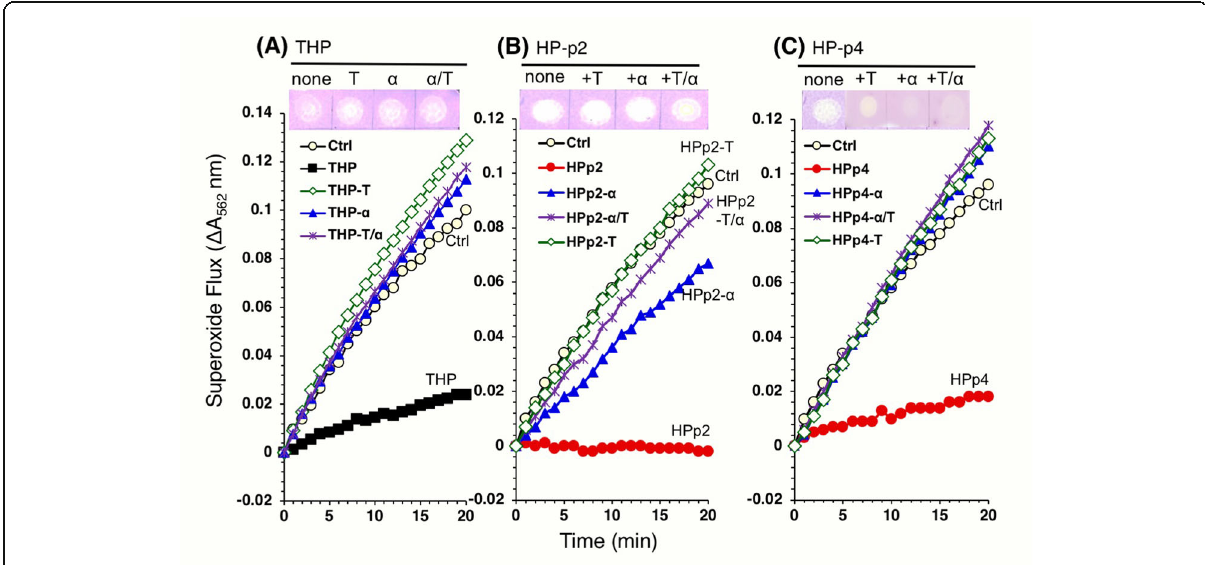
Fig. 2 Antioxidant activities of THP and its hydrolysates. The superoxide-scavenging activity was assessed at 55 μ g/mL of a intact THP or b its peptic hydrolysates at pH 2.0 (HP-p2) or c pH 4.0 (HP-p4) upon digestion with trypsin (+T), α -chymotrypsin (+ α ) or both (+T/ α ). Ctrl, reaction in the absence of protein. The corresponding DPPH reduction activities are shown on the top of each